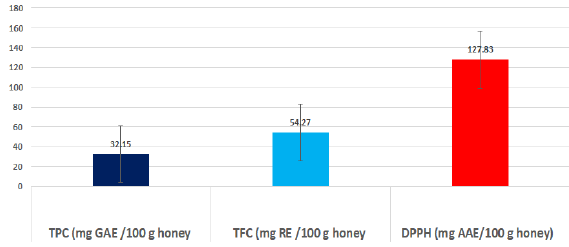
Figure 1. Total phenols, total flavonoids and DPPH in Saudi Arabia Qatada honey